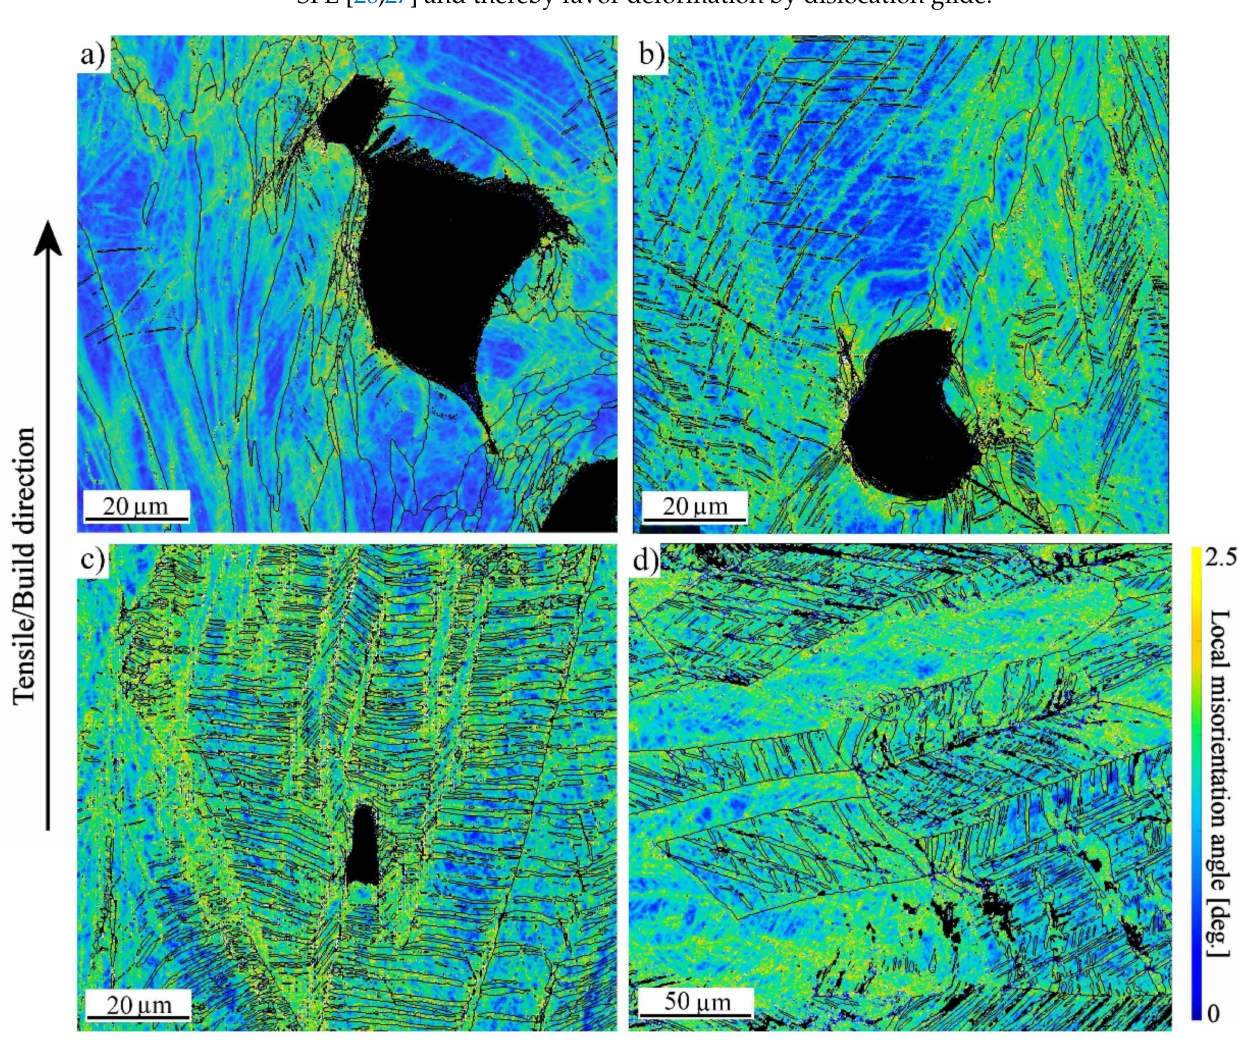
Figure 8. KAM maps of 316L strained at lower speed, fabricated with ( a ) low; ( b ) medium; ( c ) high VED; and ( d ) wrought 316L. In image ( d ) black areas correspond to α (cid:48) -martensite. Table 4. True stress-true strain values of studied 316L structures. VED = volume energy density, YS = yield